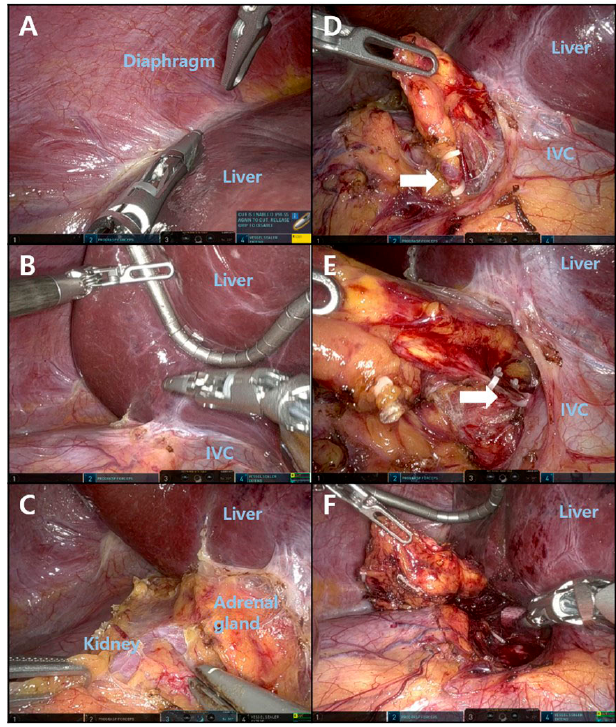
Figure 2. Procedure for robotic right adrenalectomy. ( A ) Liver mobilization. ( B ) Liver retraction and inferior vena cava identification. ( C ) Gerota’s fascia dissection and adrenal gland identification. ( D ) Adrenal vein identification. ( E ). Clipping of the adrenal vein. ( F ) Adrenalectomy completion. The steps for left RA are shown in Figure 3. The left colon was lowered by dissecting around the splenic flexure (Figure 3A). Then, the spleen was pulled downward by dissecting the splenocolic and splenophrenic ligaments (Figure 3B). After dissection around the distal pancreas and Gerota’s fascia, the location of the adrenal gland was revealed (Figure 3C). The superior pole of the left kidney was exposed, and careful dissection was performed around the adrenal gland (Figure 3D). After identifying the adrenal vein, it was ligated by hem ‐ o ‐ lock and cut (Figure 3E). The remaining soft tissue around the adrenal gland was detached, and the adrenalectomy was completed (Figure 3F).